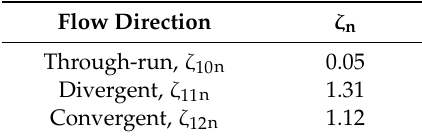
Table 2. Values of the local resistance coe ffi cient for the polypropylene T-junctions determined from the nomograms